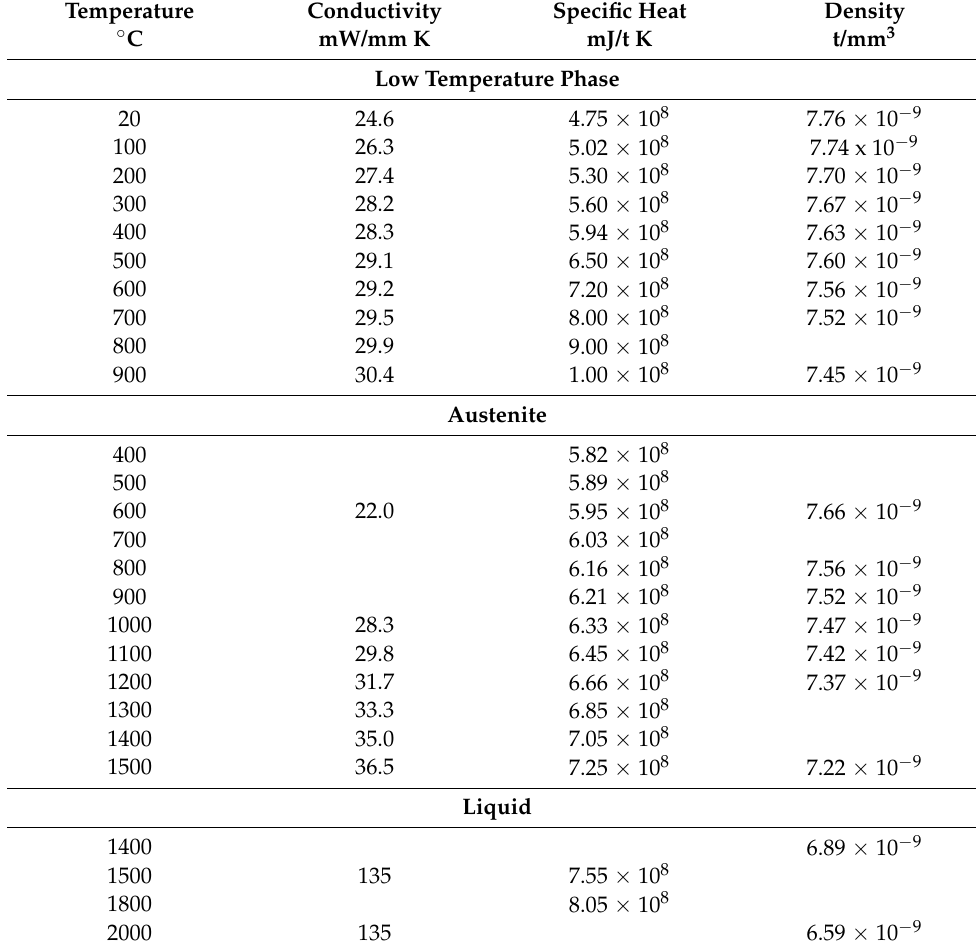
Table 4. Temperature dependent thermal conductivity λ , specific heat capacity c p , and density ρ